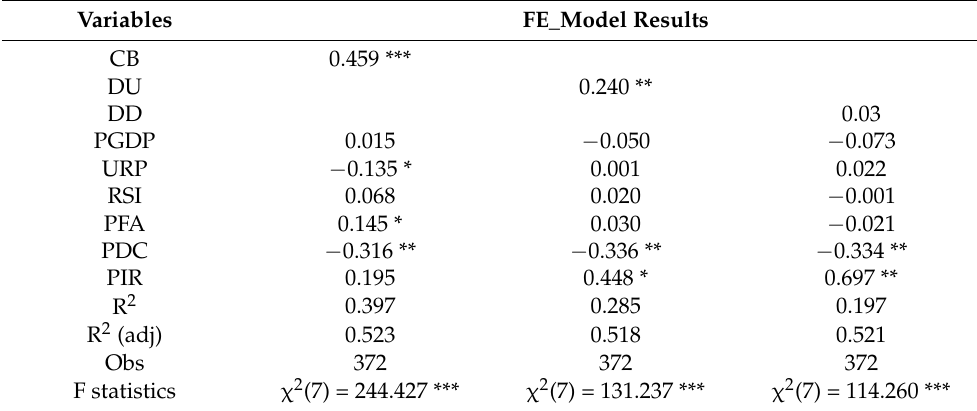
Table 5. Estimation results for the three financial development indices.